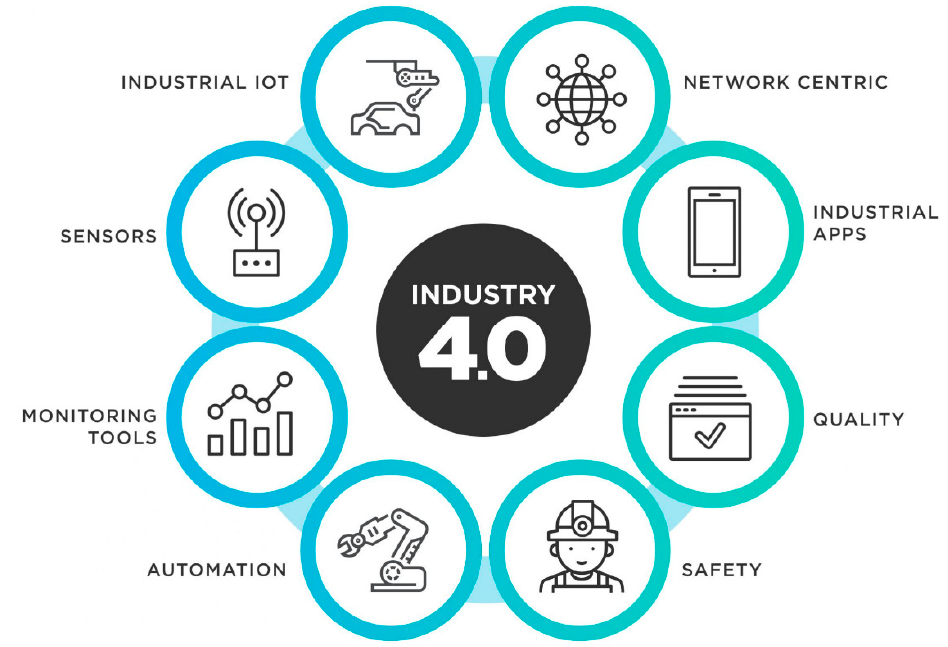
Figure 5. Tools of digitalization in industry 4.0 [45].